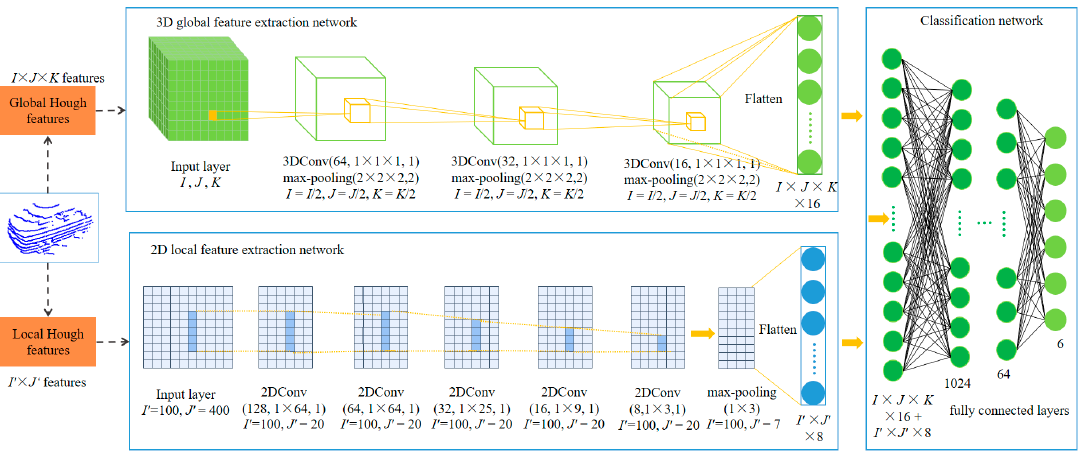
Figure 1. The framework of 2D&3DHNet for object classification in LiDAR point clouds.